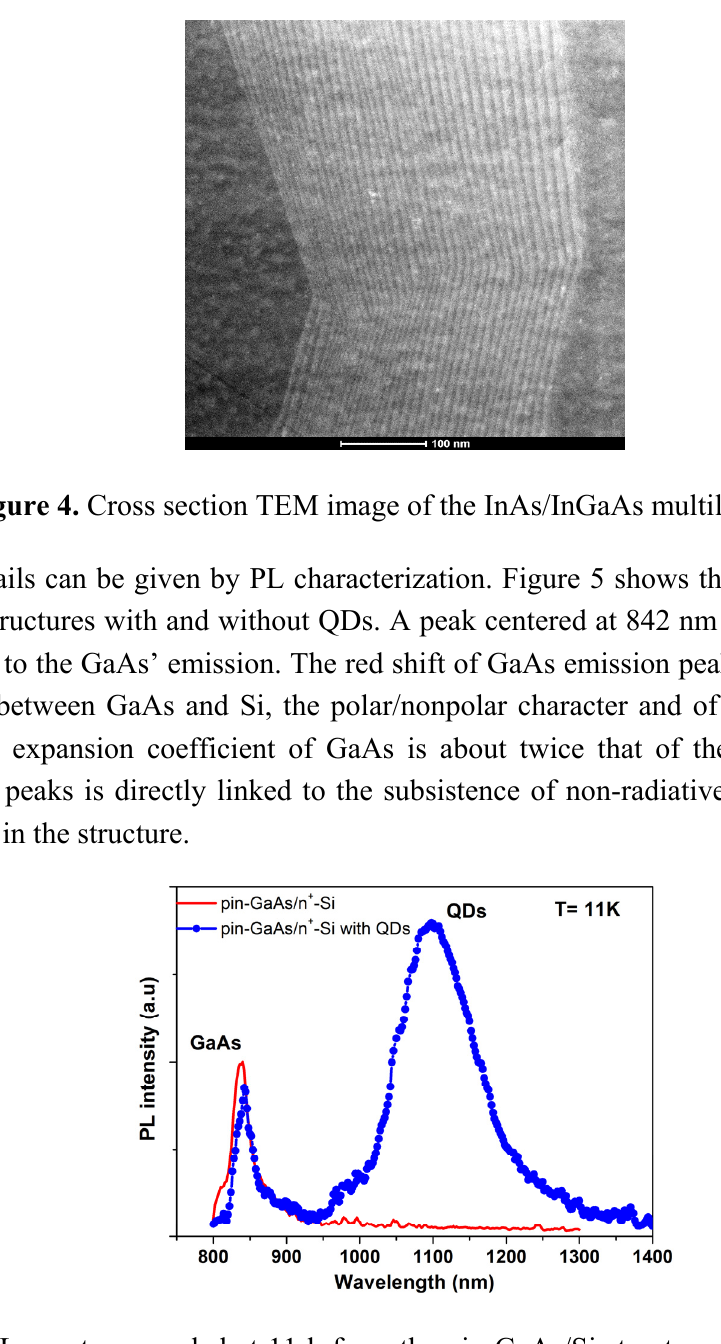
Figure 5. PL spectra recorded at 11 k from the pin-GaAs/Si structure (red line) and from pin-GaAs/Si with InAs/InGaAs multilayer QDs (blue